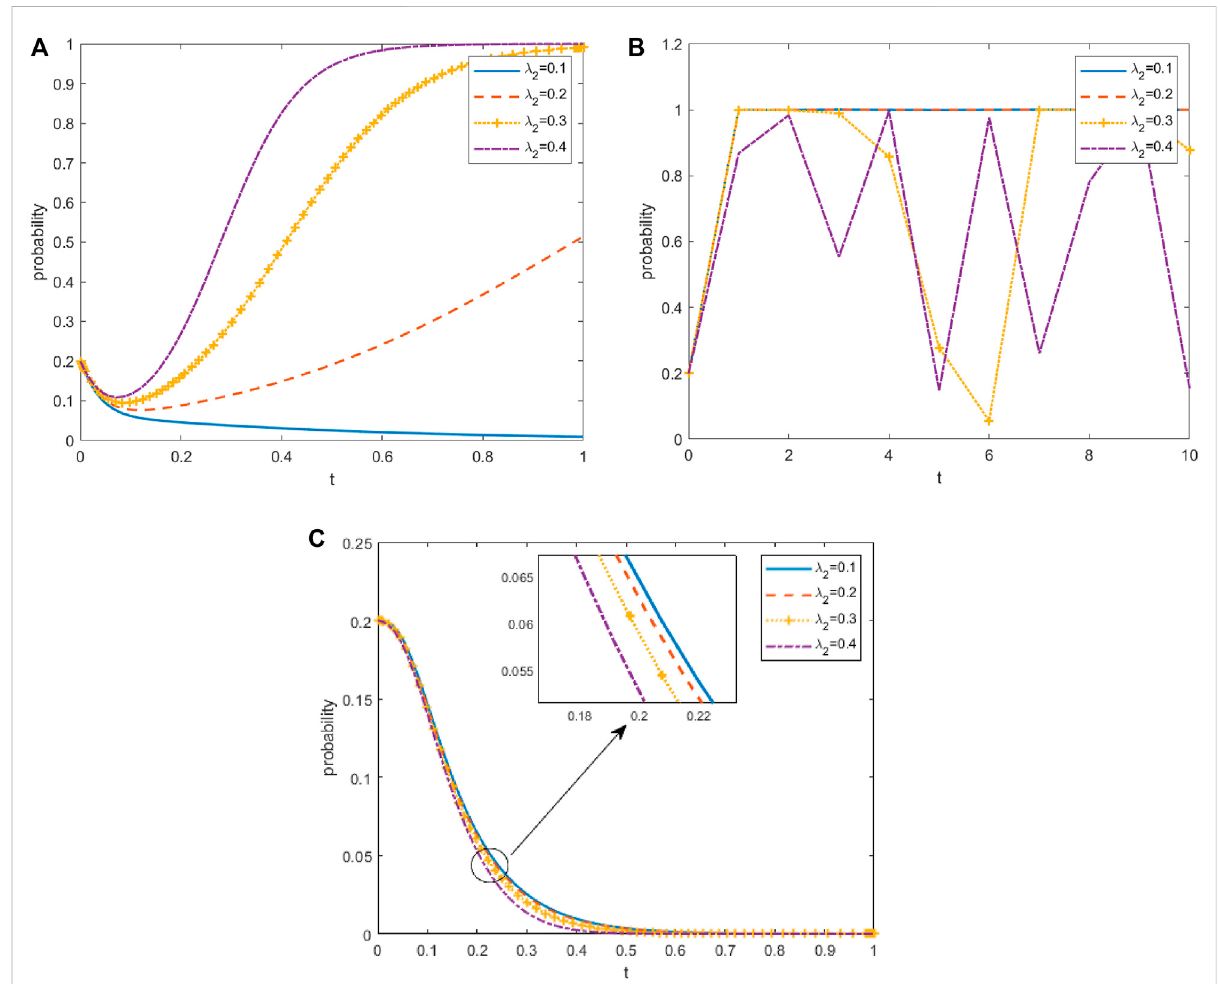
FIGURE 13 Effectof λ 2 ontheevolutionofthesystem. (A) Effectof λ 2 onfarmer ’ sstrategy, (B) Effectof λ 2 onthelocalgovernment ’ sstrategy, (C) Effectof λ 2 on the central government ’ s